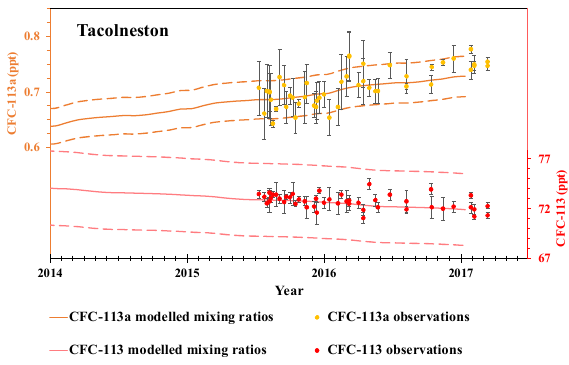
Figure 2. CFC-113a and CFC-113 modelled and observed mixing ratios at Tacolneston. The error bars represent the 1 σ standard de- viation. The modelled uncertainties are 5% and are based on the model reproducing the reported mixing ratios of CFC-11 and CFC- 12 at Cape Grim to within 5% uncertainty (Reeves et al.,